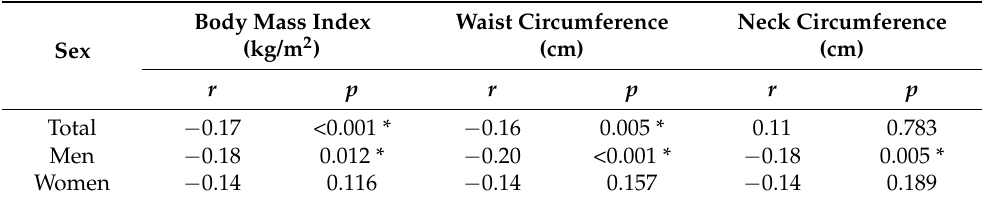
Table 3. Bivariate correlations between accelerometer-measured daily step counts and adiposity indicators stratified by sex.